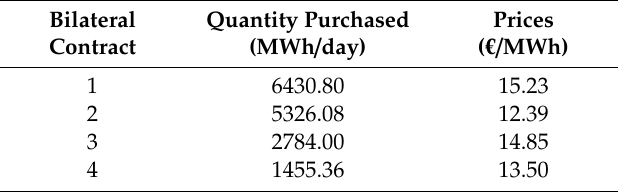
Table 6. Natural gas bilateral contracts—quantity and prices.